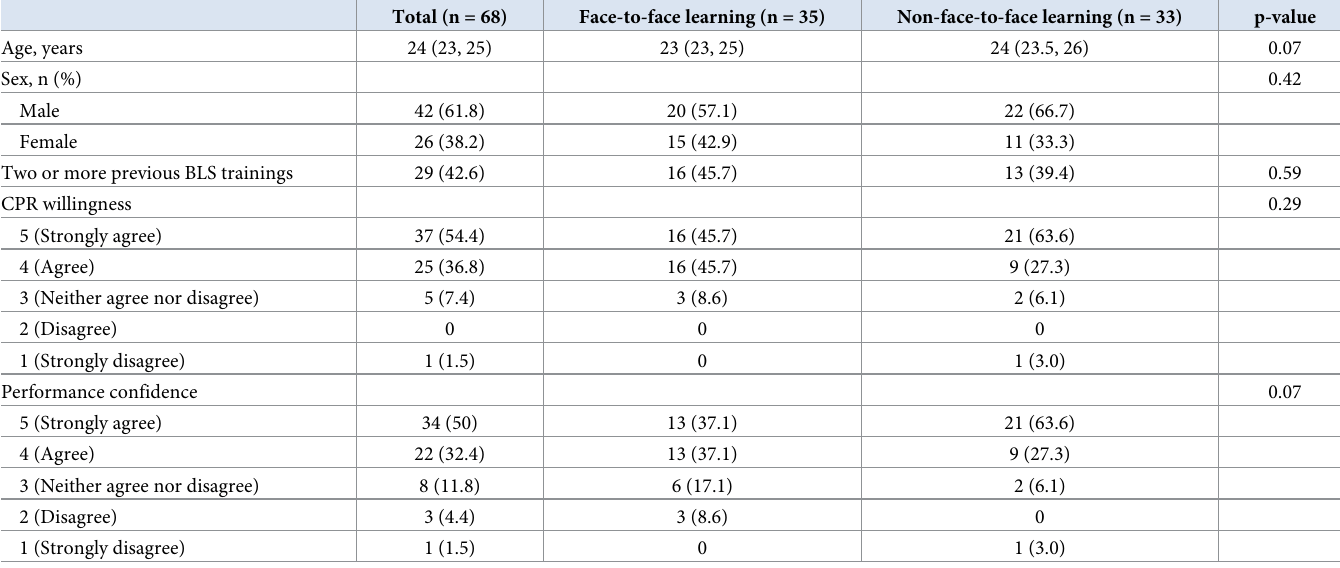
Table 2. Basic characteristics of participants in the face-to-face and non-face-to-face learning groups.